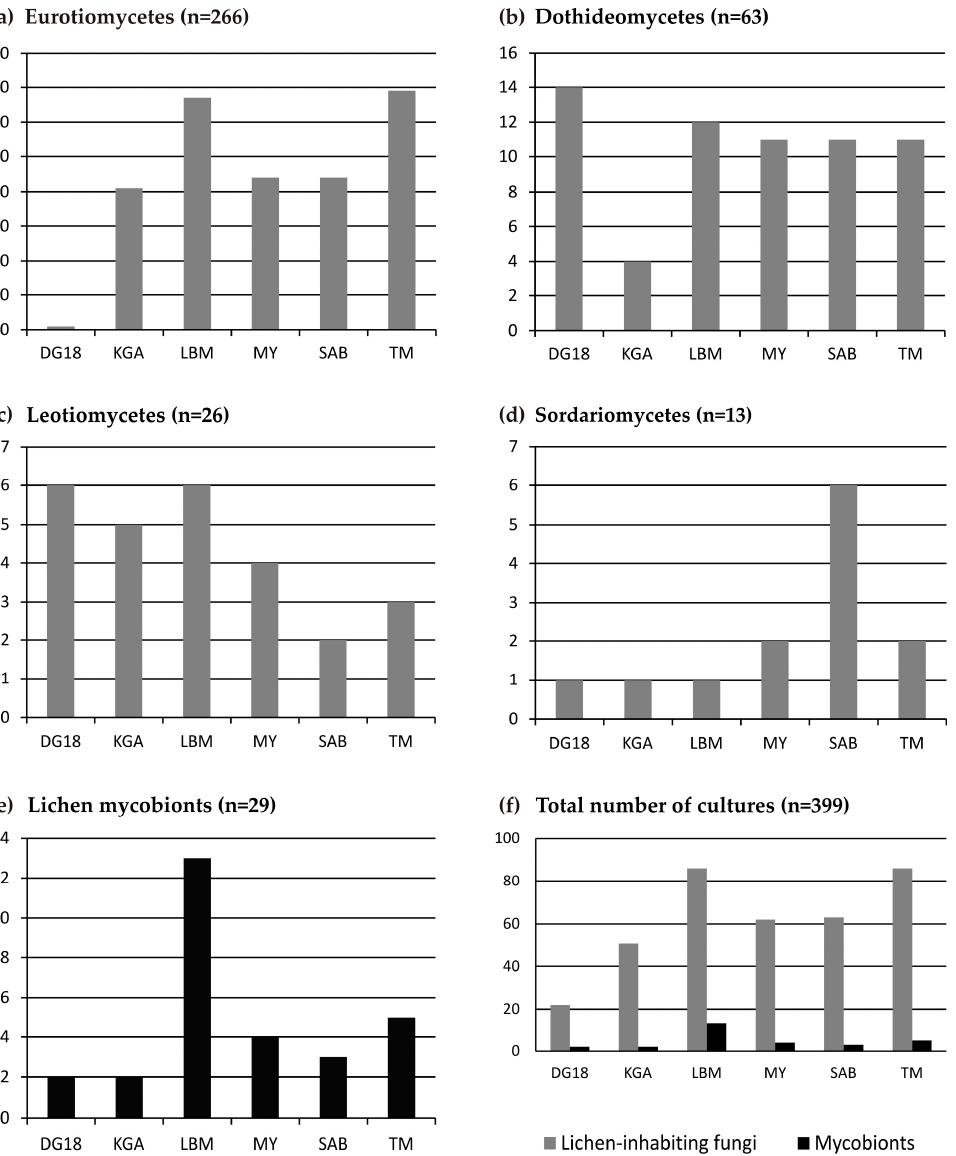
Figure 1. Abundance plots showing the growth preference of the fungal isolates on the six growth media: ( a ) Eurotiomycetes; ( b ) Dothideomycetes; ( c ) Leotiomycetes; ( d ) Sordariomycetes; ( e ) lichen mycobionts; ( f ) total number of lichen-inhabiting fungal isolates compared with isolates of the lichen mycobionts. DG18: Dichloran/Glycerol agar, KGA: PDA Potato/Dextrose agar, LBM: Lilly and Barnet medium, MY: Malt Yeast-extract, SAB: Sabouraud, TM: Trebouxia medium.